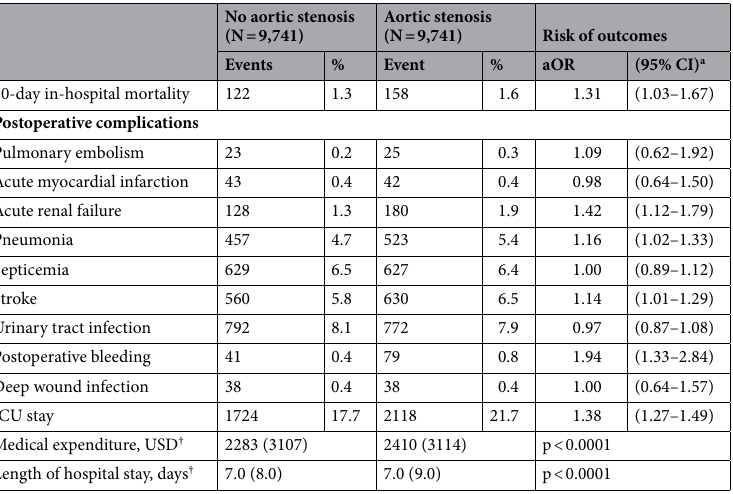
Table 2. Adverse outcomes after non-cardiac surgeries in patients with aortic stenosis (after matching). CI confidence interval, aOR adjusted odds ratio. a Adjusted for all covariates listed in Table 1. † Median (interquartile